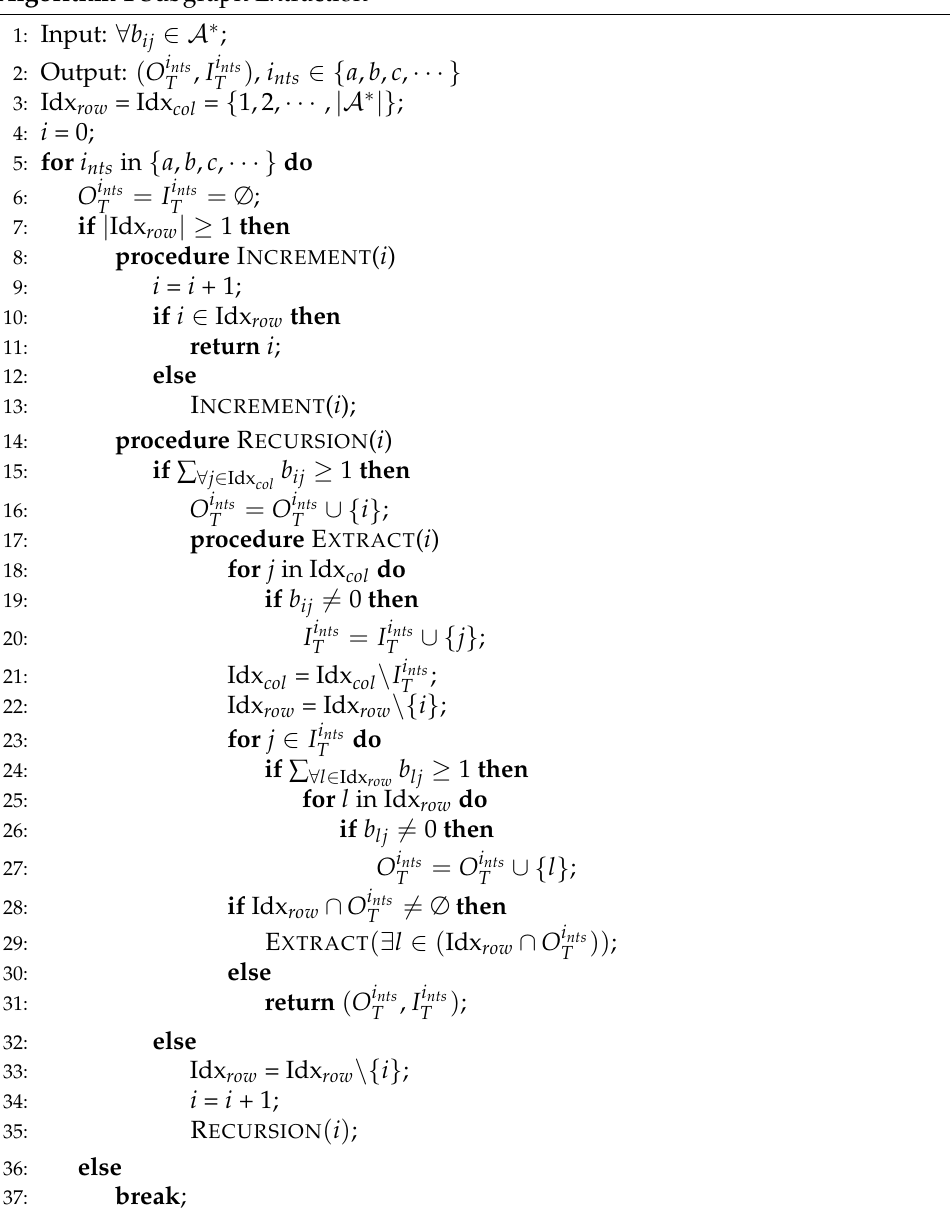
Algorithm 1 Subgraph